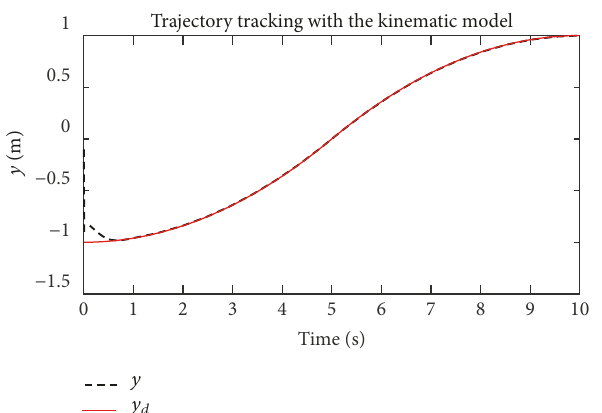
Figure 9: The 𝑦 trajectory tracking using the predictive control joined with the kinematic model.